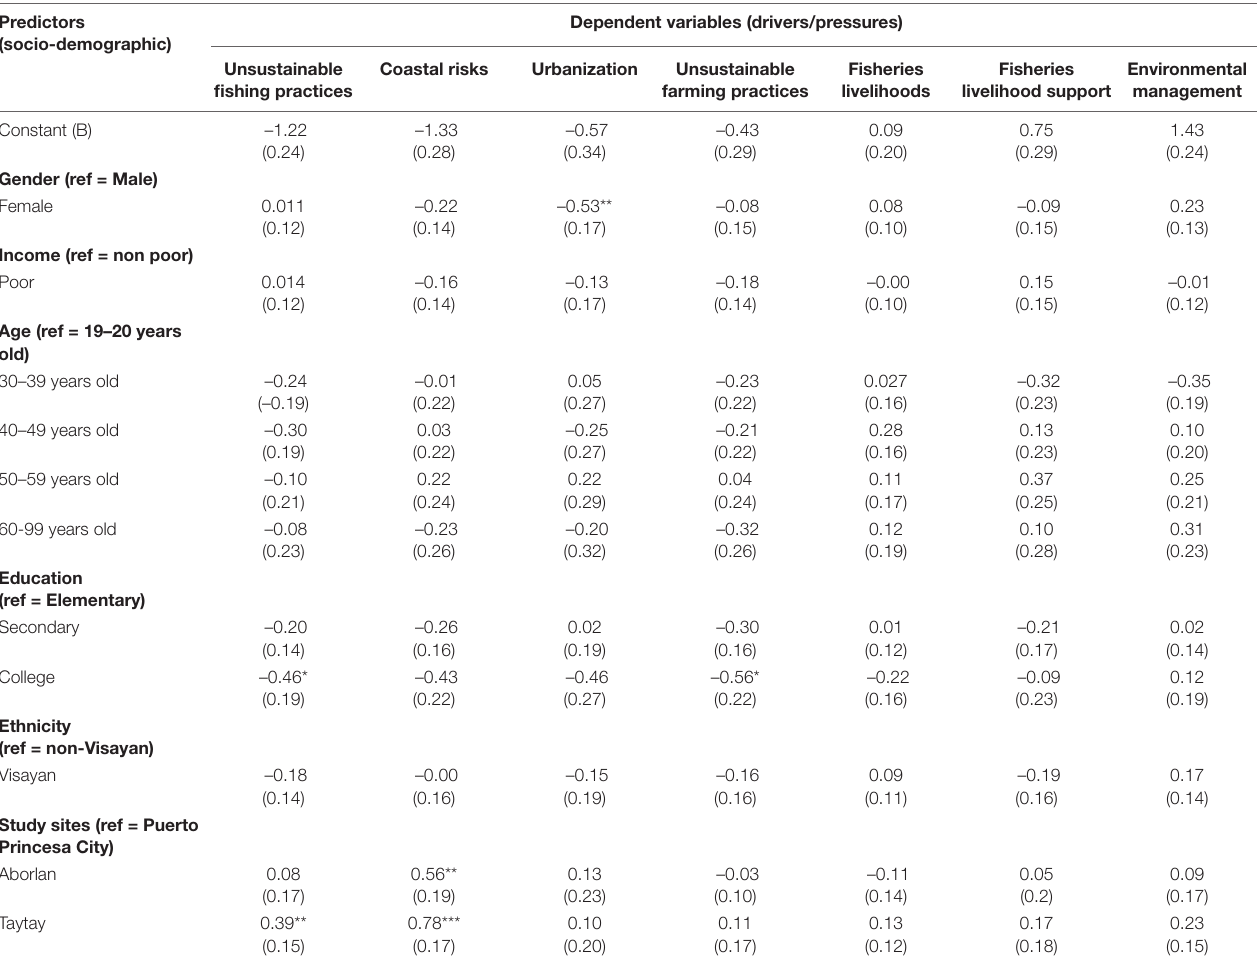
TABLE 3 | Results of ordinary least square regression model predicting perceptions of the drivers/pressures in the coastal marine environment of Palawan, Philippines from key socio-demographic variables (standard errors in parentheses). Predictors